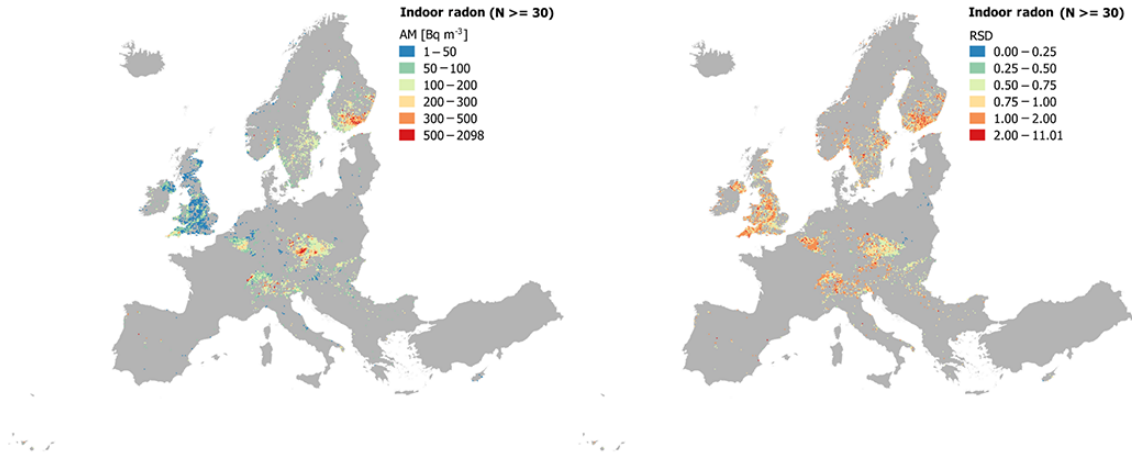
Figure 11. Grids with 30, or more, indoor radon measurements ( N = 4173; AM: arithmetic mean in becquerels per cubic metre; RSD: relative standard deviation in percent).